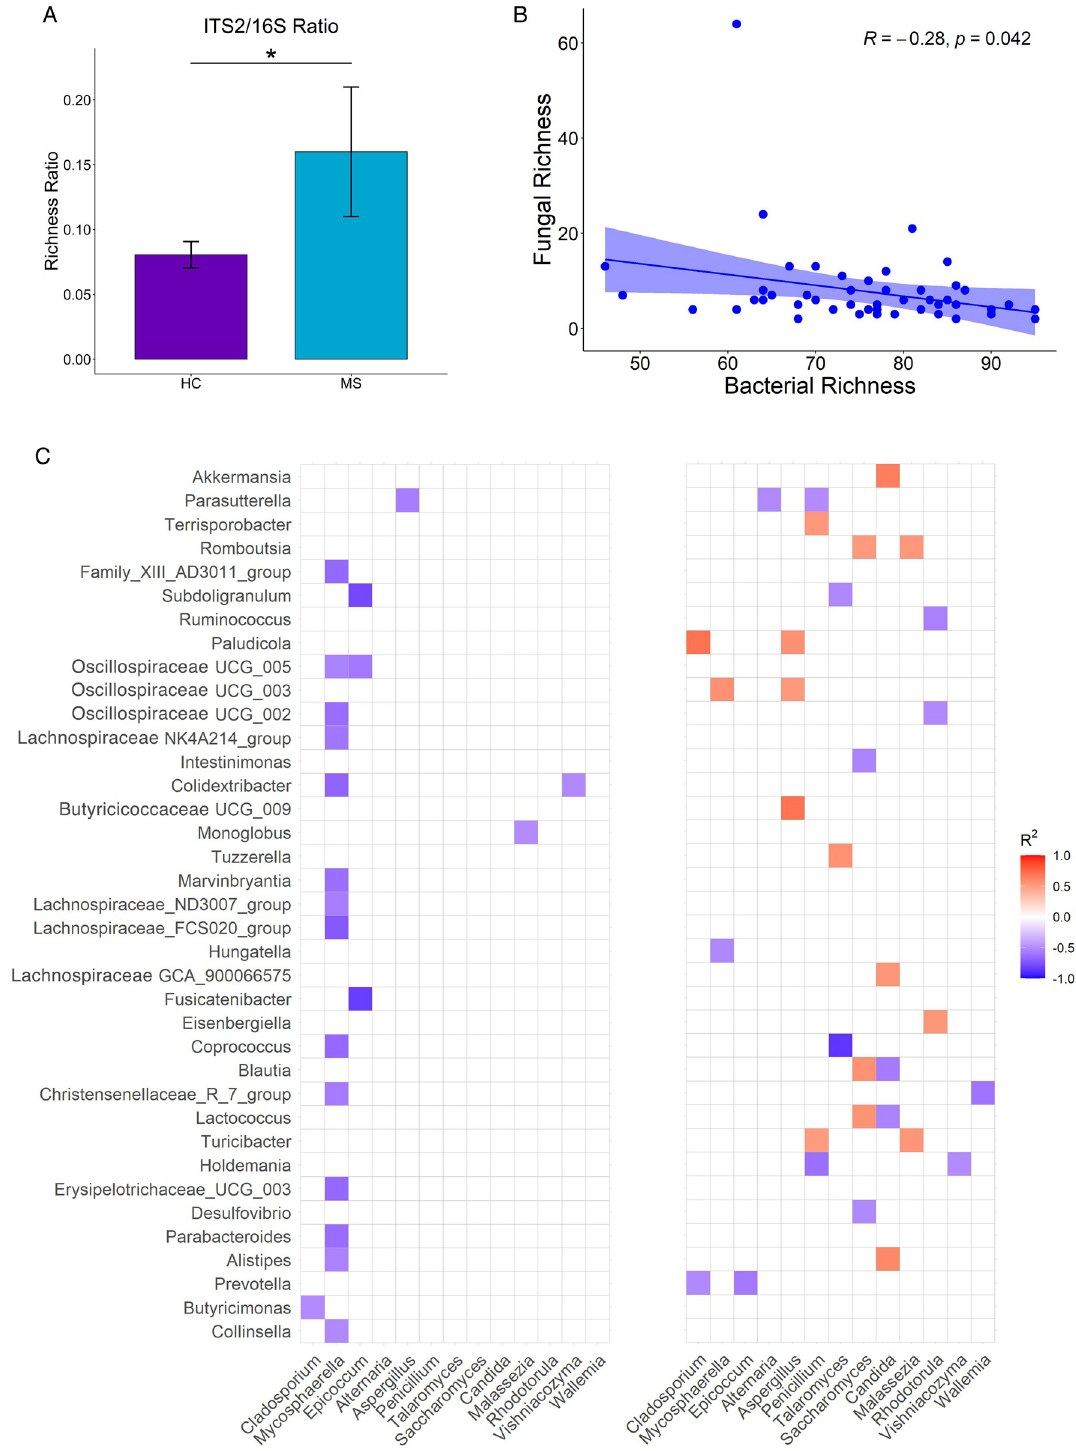
Fig 5. Correlation between gut mycobiome and microbiome. (A) Ratio of ITS2 to 16S compared between groups. (B) Linear regression of fungal and bacterial richness shows a negative correlation (Spearman’s R = -0.28, p = 0.042). (C) Correlation matrix between bacteria and fungi using Spearman correlation. Values range from -1 to 1 with positive values as orange and red and negative values as purple and blue (-1 � R � 1). Only statistically significant correlations (p < 0.05) are shown.